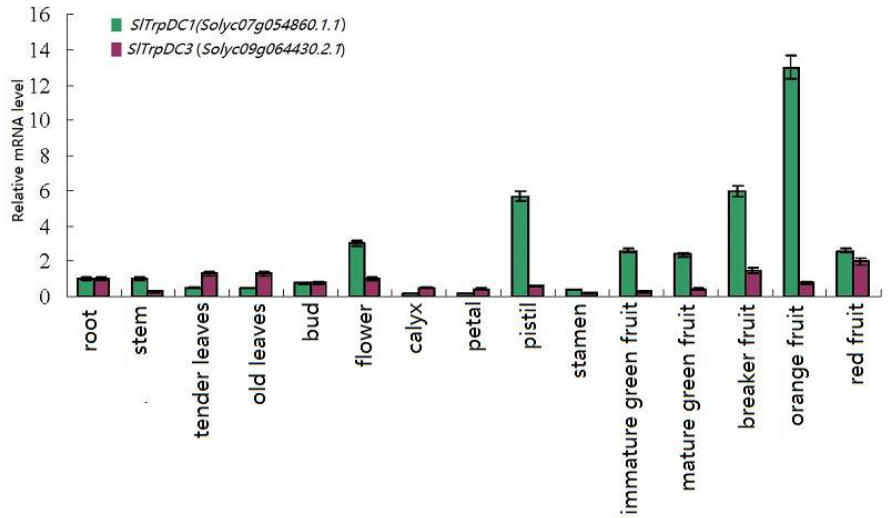
Figure 4. Expression profiles of the SlTrpDC genes in different tissues in tomato. The expression levels of these SlTrpDC genes in fifteen tissues were tested using RT-qPCR, including root, stem, tender leaves, old leaves, bud, flower, calyx, petal, pistil, stamen, immature green fruit, mature green fruit, breaker fruit, orange fruit and red fruit. Error bars represent standard deviations from three independent technical replicates.